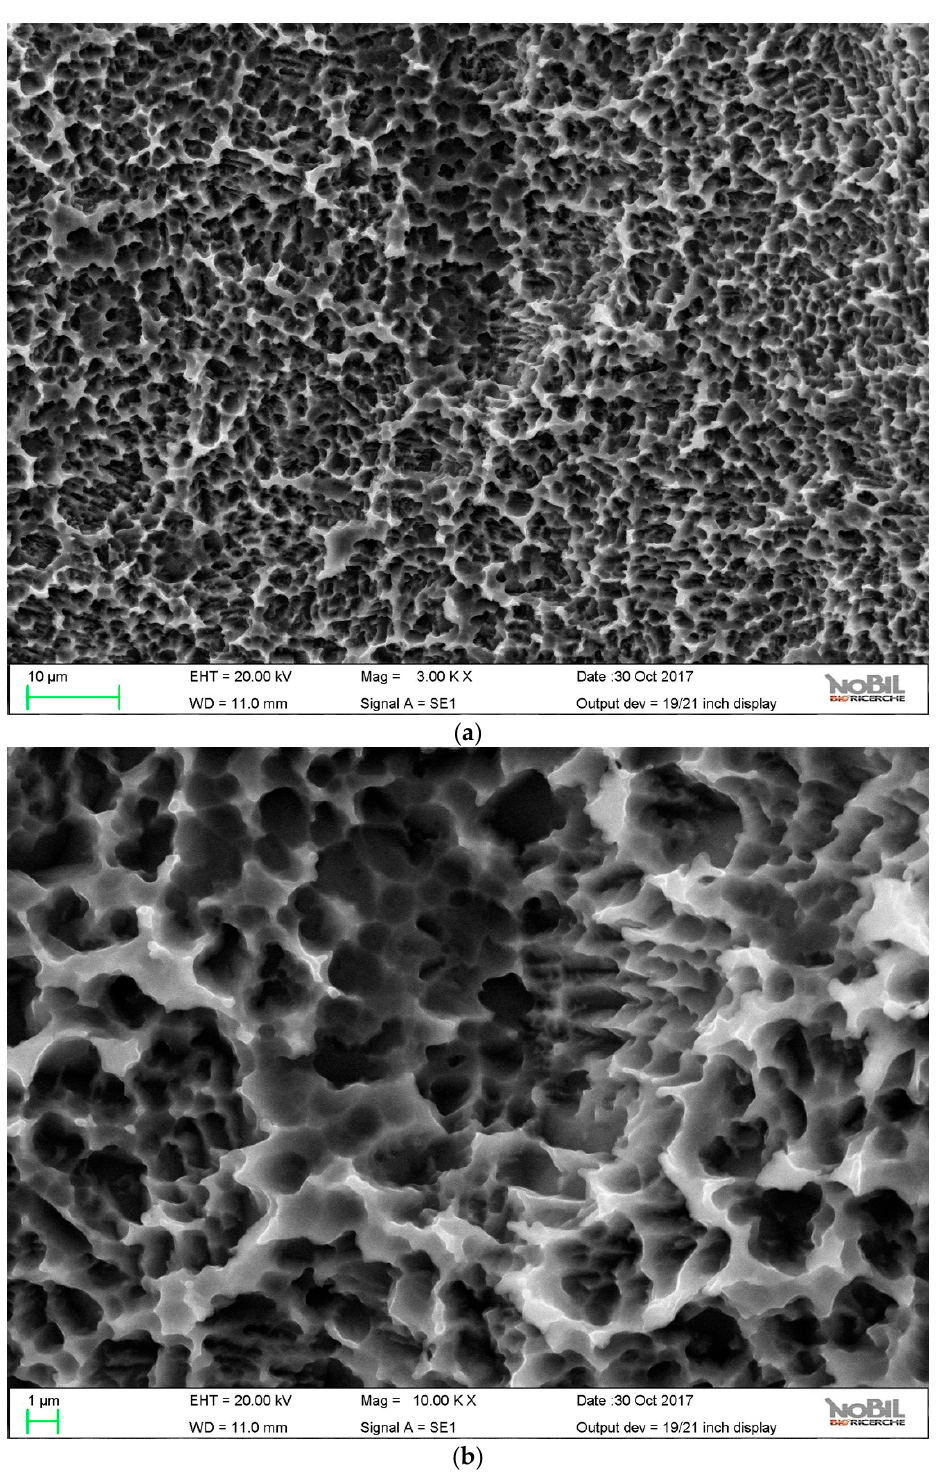
Figure 3. SEM images of the hyaluronan- (HY) coated implant surface, ( a ) 3000 × ; ( b ) 10,000 × . Both samples showed the typical microtopography of doubly acid etched surfaces—a microrough surface where the distance between peaks was of the order of the micrometer. As reported in the literature, a peak distance lower than the typical cell length can stimulate cell behavior, thus promoting accelerated osteogenesis [54,55]. No evidence of the HY coating was observed, even at 10,000 × . Surface linking of HY involved just molecular layers, whose thicknesses were approximately a